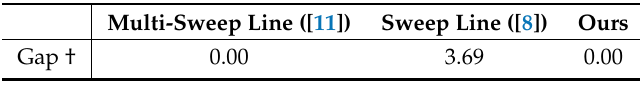
Figure 11. Convex decomposition for the polygon P 1 by our method. Table 1. Performance comparison with P